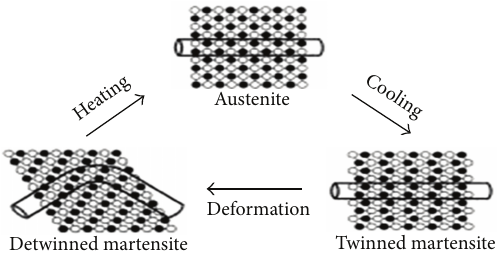
Figure 3: Diagrammatic representation of the shape memory effect of NiTi alloy. Source: